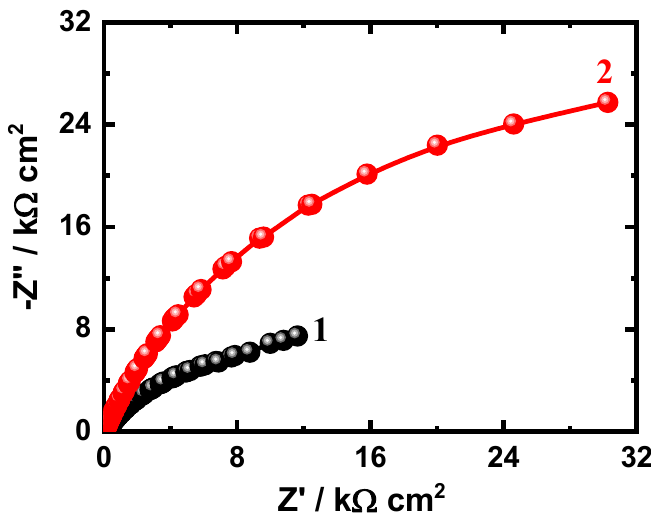
Figure 4. Nyquist plots for (1) Ti and (2) Ti85-Zr15 after 1.0 h exposure to SBF.